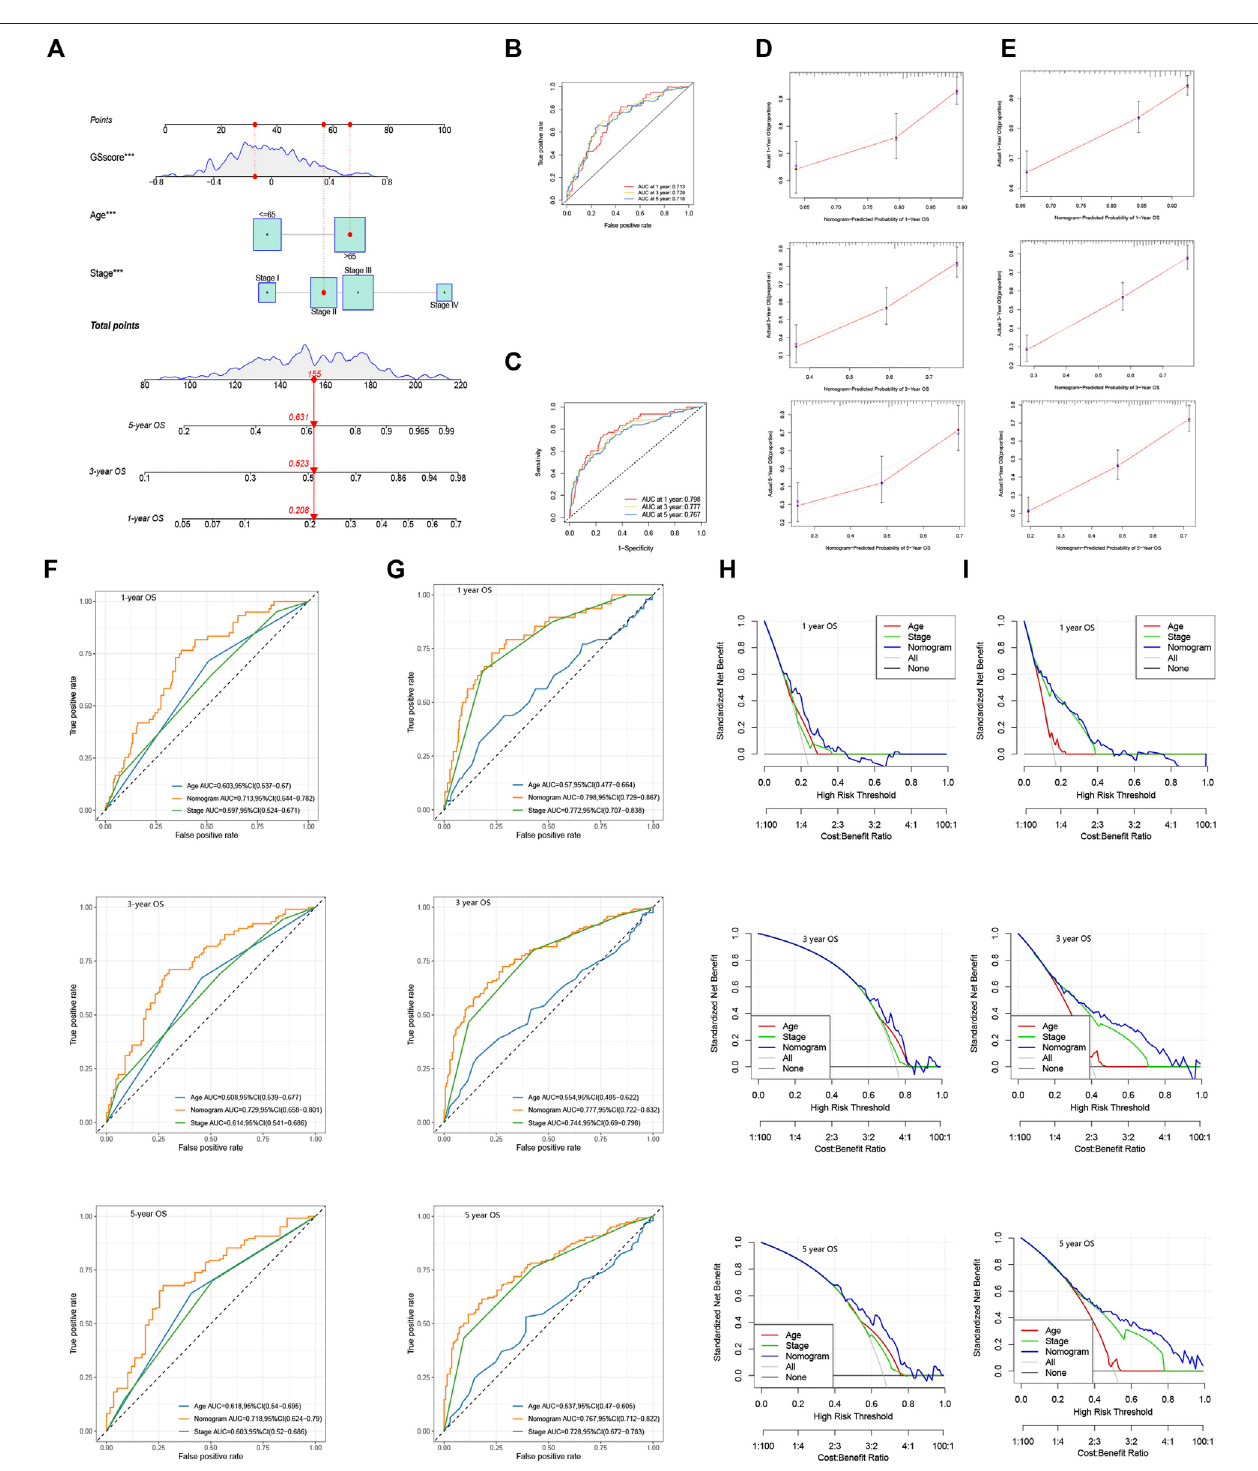
FIGURE10| Construction ofanomogramusingGSmodel. (A) Nomogram integrating GSscore,age,and tumor stageforpredicting 1,3,and5 yearOSinTCGA andGSE62254.1,3,and5 yearROCanalysesofthenomogramin (B) TCGAand (C) GSE62254.Calibrationcurvesofthenomogramforpredicting1,3,and5 yearOS in (D) TCGA and (E) GSE62254. Time-dependent ROC curves evaluating the ef fi cacy of the nomogram to predict 1, 3, and 5 year OS in (F) TCGA and (G) GSE62254. DCA curves estimating the predictive ef fi cacy of the nomogram in (H) TCGA and (I) GSE62254.